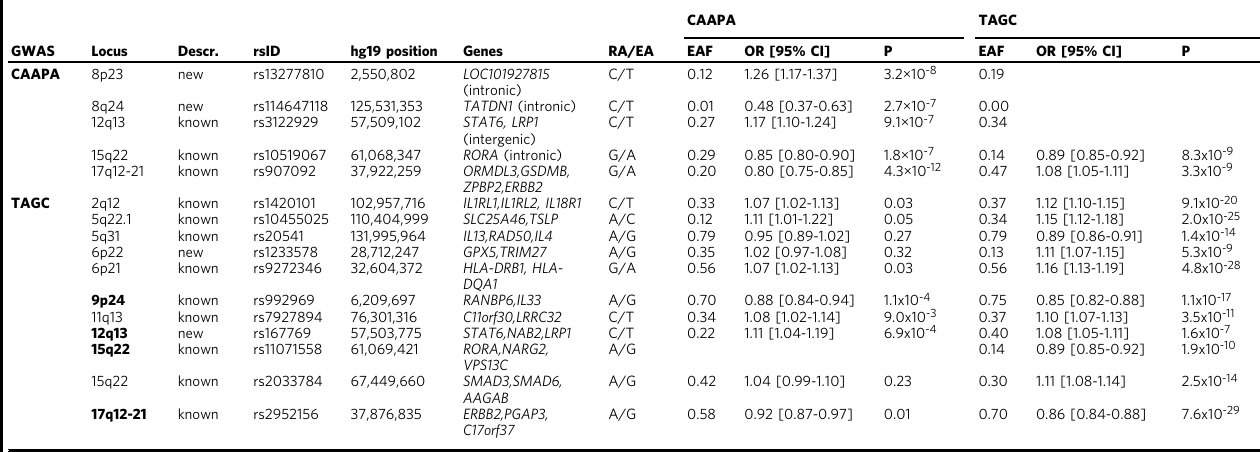
correction for 810 association tests: chromosomes 9p24